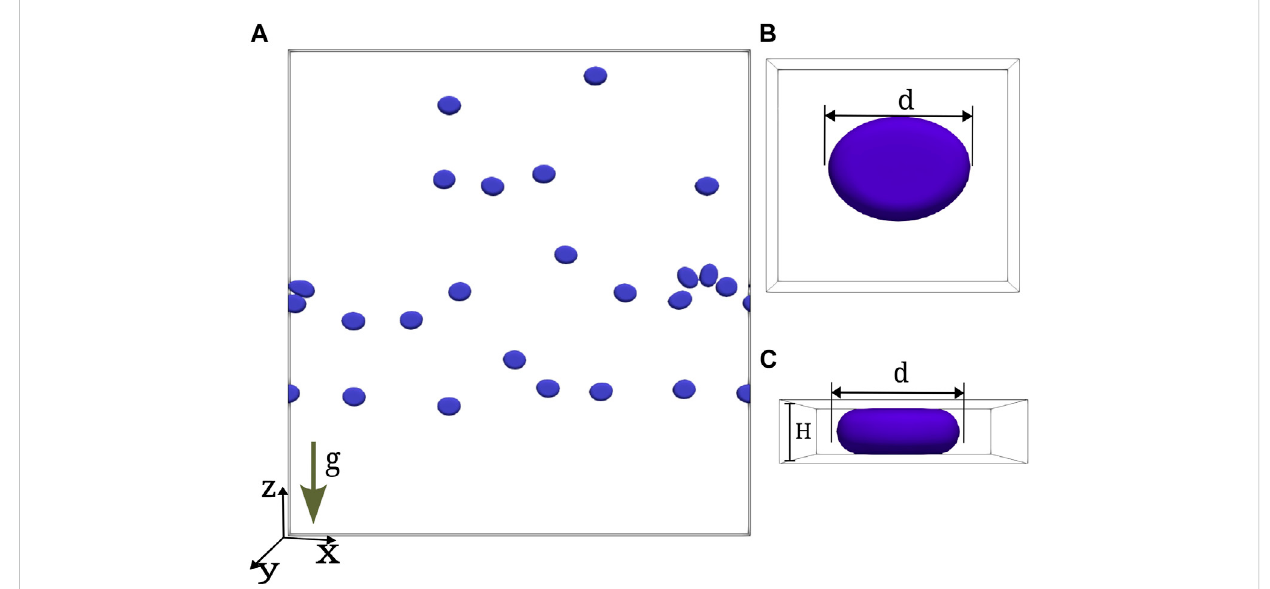
FIGURE 1 (A) Representative plot showing bubbles of diameter d in a Hele-Shaw setup. The length along x − and z − directions is L , and the gap width in y − direction is H ; (B) Top view of a bubble (zoomed view); (C) Front view of the bubble (zoomed